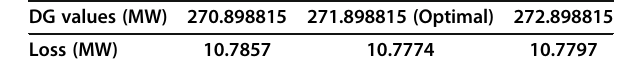
Table 20 Comparison of power loss at the IEEE 57 bus system with different DG power placed at bus no. 13 using the JAYA